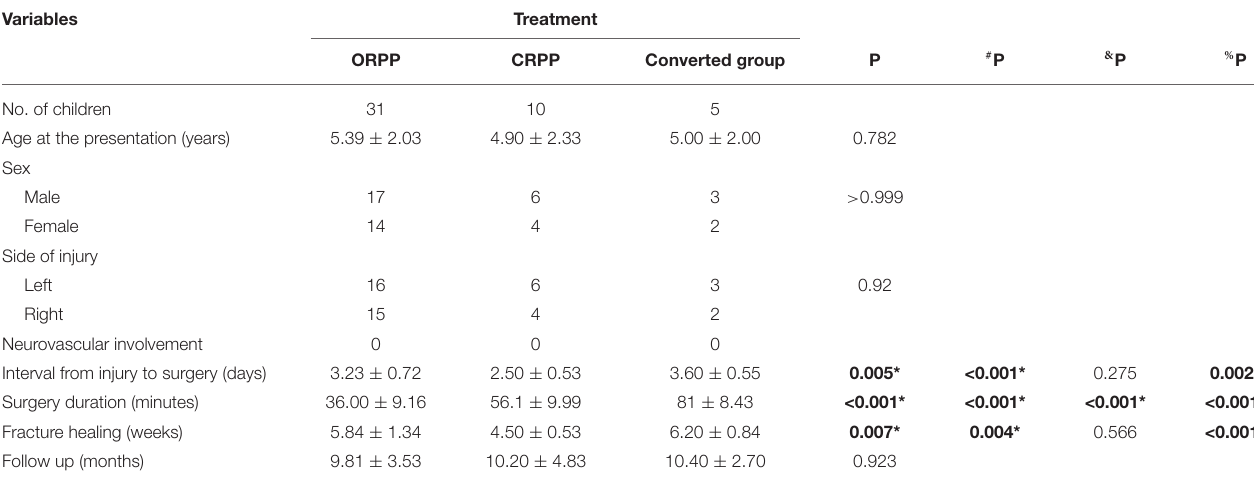
TABLE 1 | General descriptive data of three groups.